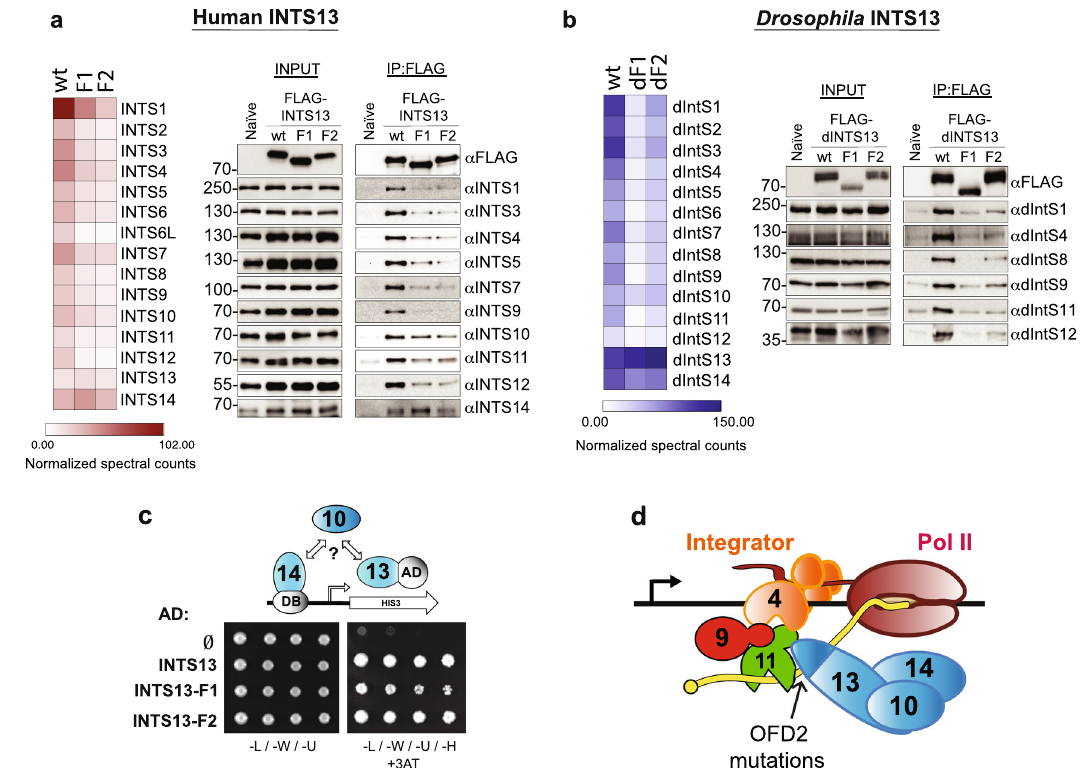
Fig. 4 | INTS13 patient variants disrupt interactions between the INTS10/13/14 module and the Integrator complex. a Immunoprecipitation of FLAG-INTS13 from nuclear extract derived from HEK-293T cells stably expressing FLAG epitope tagged human INTS13-wild type (wt), Family 1 INTS13 mutant (F1), or Family 2 INTS13 mutant (F2). Nuclear extract derived from naïve HEK-293T cells not expressing any FLAG epitope wasusedas a control.Leftpanel:IP-LC/MS wasdone for each sample, and quantitation is shown as a heat map. Results from the MS experiments were quanti fi ed from triplicate experiments, while the IP/WB was conducted in duplicate with representative images shown in the panel. The color scale shown denotes the normalized spectral counts for each protein (see meth- ods).Rightpanel:westernblot analysisof eithernuclearextractinputoranti-FLAG immunoprecipitation using human Integrator antibodies with molecular weight markers shown are in kilodaltons. b Results shown are from parallel experiments conducted in a manner identical with panel ( a ) with the exception that nuclear